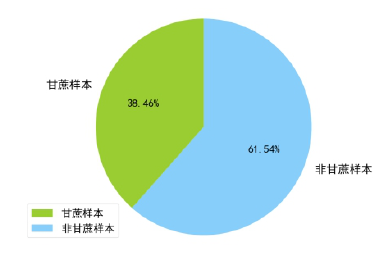
Figure 2. Sugarcane sample